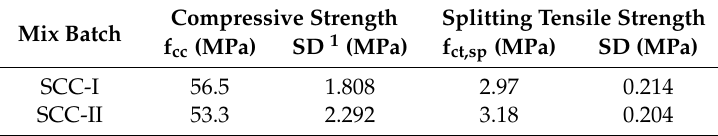
Table 3. Results of compressive strength and splitting tensile strength tests.